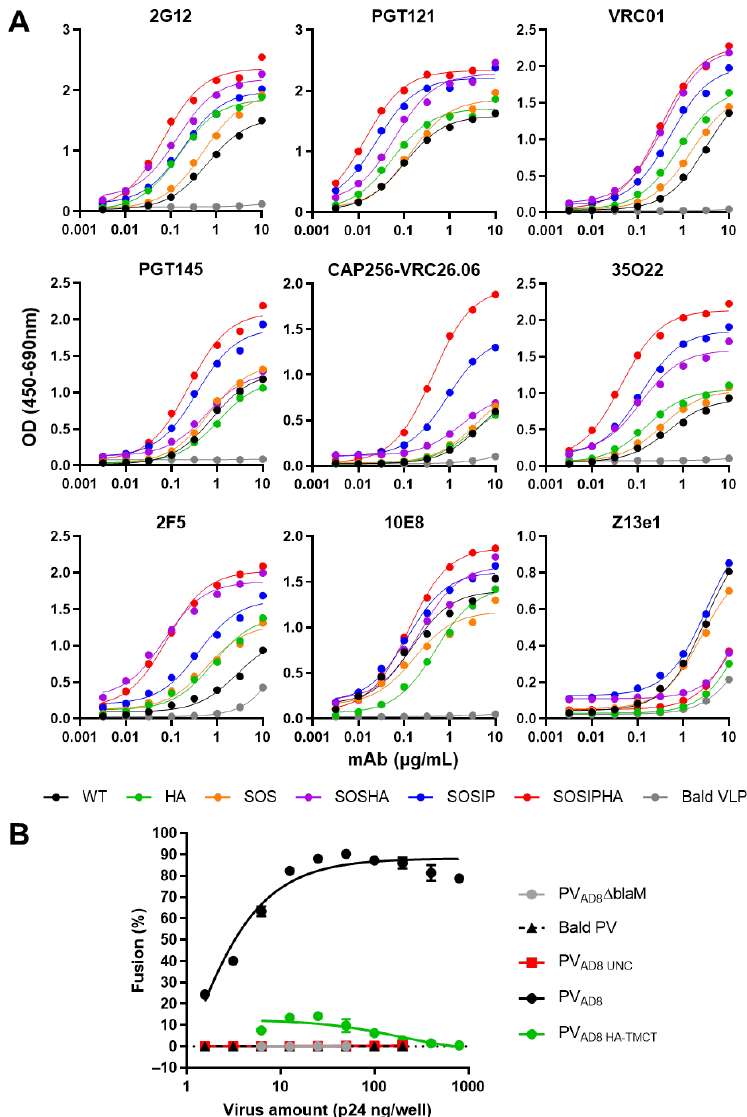
Figure 4. Antigenicity and fusion function of Env with or without a HA TM and CT domain expressed on mVLPs and HIV-1 pseudovirions. ( A ) Representative ELISA binding curves of VRC01, PGT121, 2G12, PGT145, CAP256-VRC26.06, 35O22, 2F5, 10E8, and Z13e1 to mVLP particles expressing cleavage-competent gp160 without (WT) or with a SOS or SOSIP modification (SOS or SOSIP, respectively), or the same set of gp160 sequences containing a haemagglutinin (HA) TM and CT (HA, SOSHA, and SOSIPHA, respectively), and mVLPΔenv particles (Bald VLP). VLP ELISAs were performed using an equal number of particles/well as determined by p24 ELISA (data not shown). ( B ) Fluorescent fusion assays with NL4-3 pseudovirus bearing no Env (Bald PV), uncleaved AD8 gp160 (PV AD8 UNC), wild-type AD8 gp160 (PV AD8 ), and wild-type AD8 gp160 containing a HA TM and CT (PV AD8 HA-TMCT ). PV AD8 ΔblaM particles lacked the BlaM-Vpr fusion protein. The amount of virus was determined by p24 ELISA, and CEM.NKR CCR5+ cells were used as target cells. Values represent the mean and SEM of duplicate measurements.